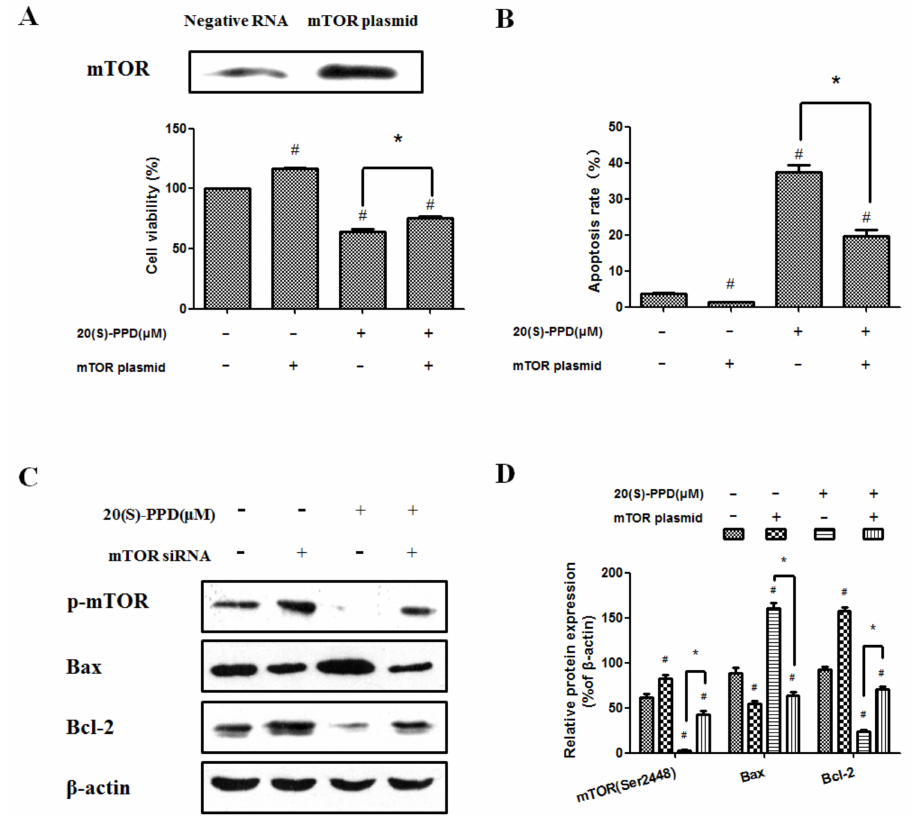
Figure 4. 20(S)-PPD-induced apoptosis was reversed by transfection with mTOR plasmid. ( A ) Expression of mTOR after transfection of mTOR plasmid was viewed by Western blot (upper line). After 20(S)-PPD (30 µ M) treatment in MCF-7 cells for 24 h, the MTT assay was used to determine the cell viability (lower line). ( B ) Flow cytometry was used to measure the apoptosis rate after 20(S)-PPD (30 µ M) treatment for 24 h. ( C , D ) After 20(S)-PPD (30 µ M) treatment of MCF-7 cells for 24 h, Western blot was used to determine the expression of Bax, Bcl-2 and p-mTOR. All data presented were represented as mean ± S.D. # p < 0.05 compared to control group, * p < 0.05 compared to 20(S)-PPD (30 µ M)